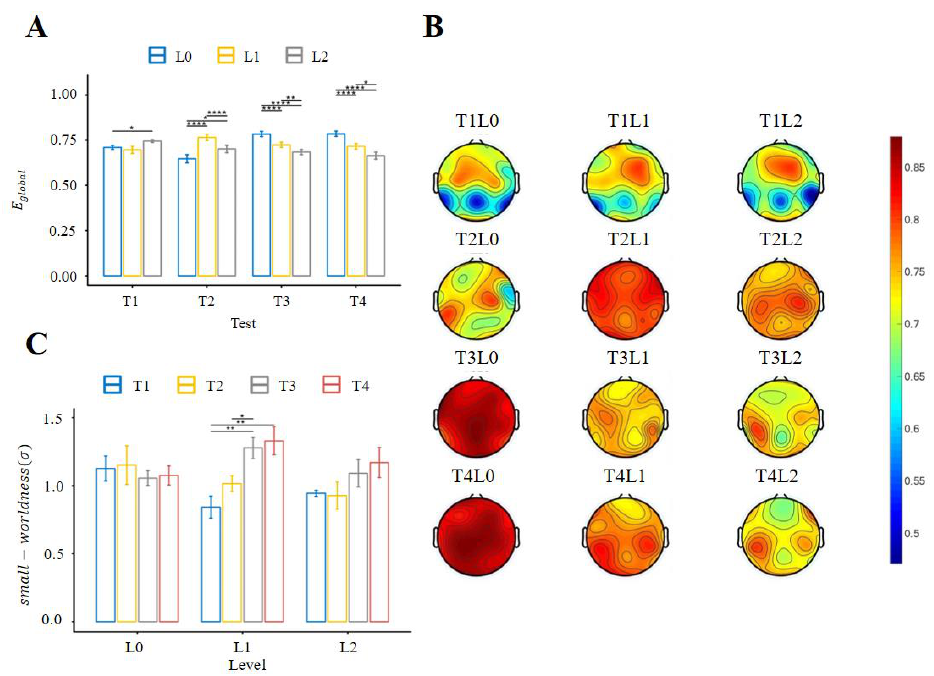
Figure 4. Statistical results of brain network metrics as the task difficulty and test order changed. ( A ) Global efficiency. ( B ) Grand average local efficiency for each channel (T for Test, L for Level). ( C ) Small-worldness. (*: p < 0.05, **: p < 0.01, ****: p < 0.0001 after correction). The error bars indicate the standard error of the mean (SEM).